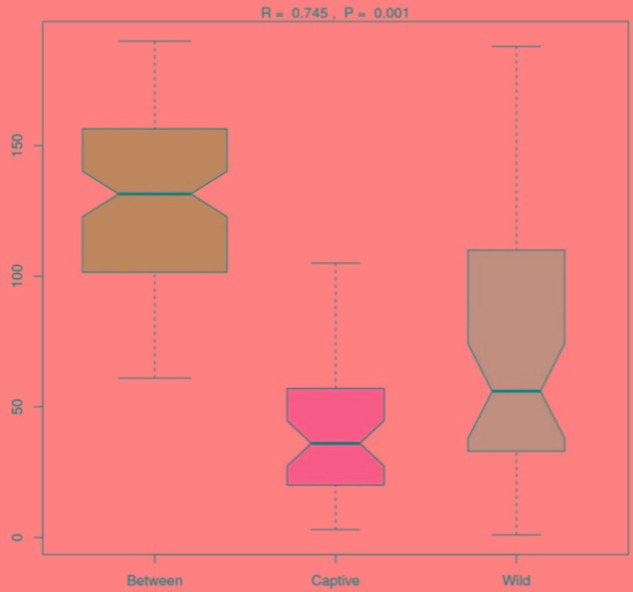
ANOSIM analysis. R-value: R-value range (–1, 1). Actual results are generally between 0 and 1. An R-value close to 0 represents no significant inter-group and intra-group differences. A R-value close to 1 shows that inter-group differences are greater than intra-group differences. P-value: The P-value represents the confidence level of the statistical analysis; P < 0.05 reflects a statistically significant difference. The y-axis represents the distance rank between samples, and the x-axis represents the results between both groups. Intra-group results are shown for each group. In the plot, the R-value was close to 1, indicating that inter-group differences were greater than the intra-group differences, and P < 0.05 shows that this result was statistically significant.